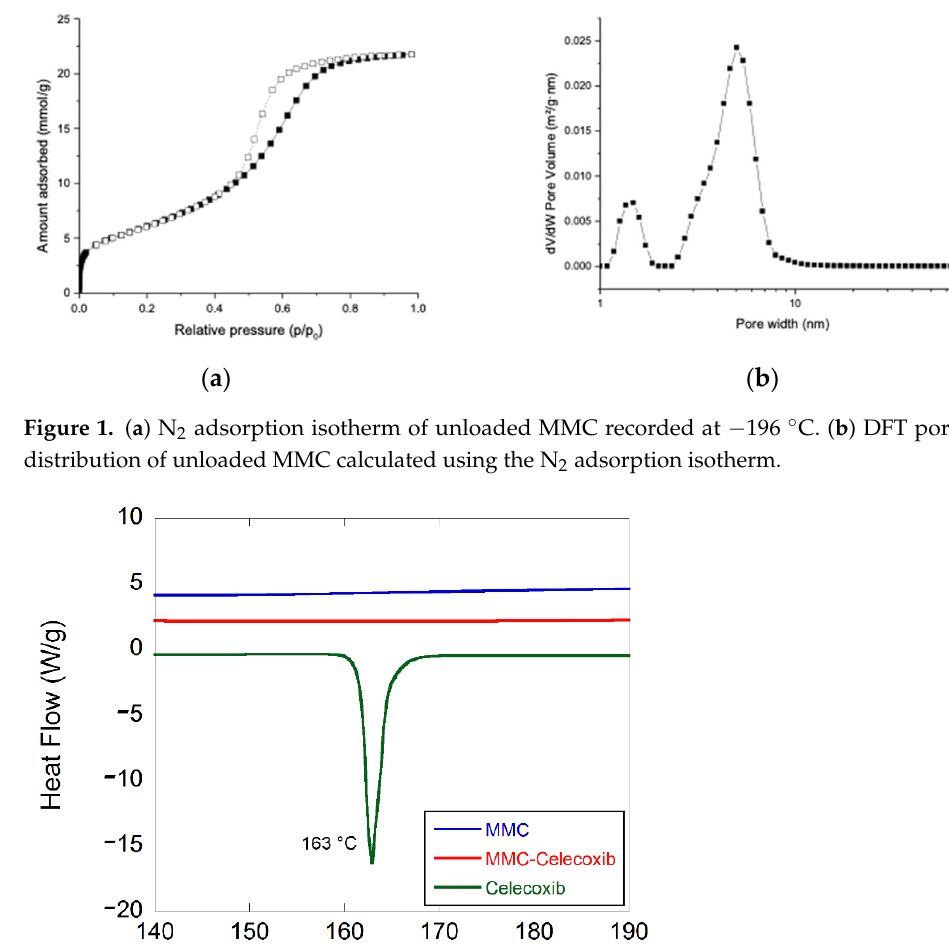
Figure 1. ( a ) N 2 adsorption isotherm of unloaded MMC recorded at − 196 °C. ( b ) DFT pore size dis- tribution of unloaded MMC calculated using the N 2 adsorption isotherm .